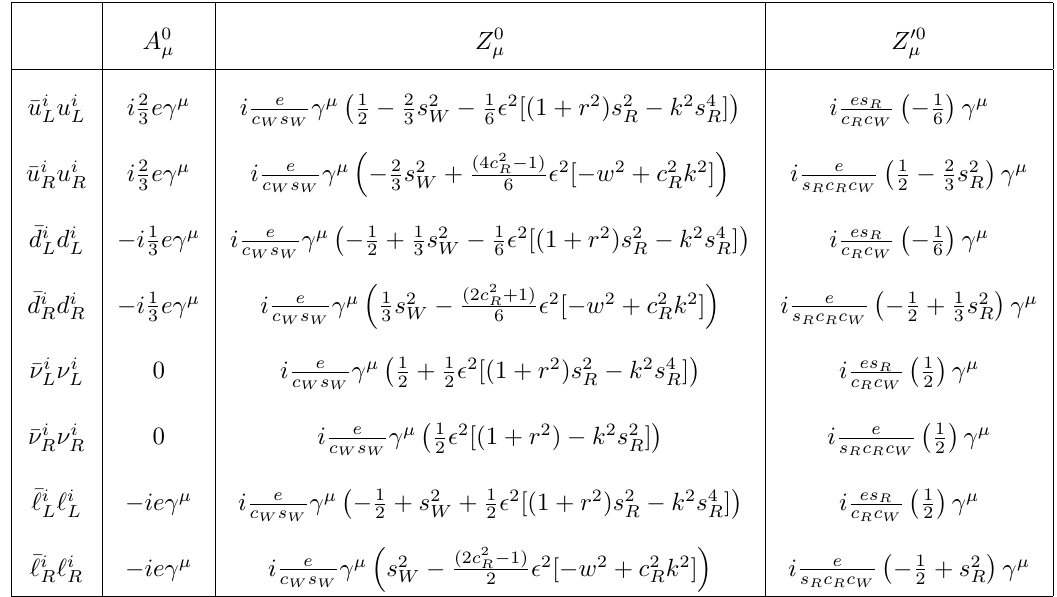
Table 5 . Couplings of neutral gauge bosons to quarks and leptons.